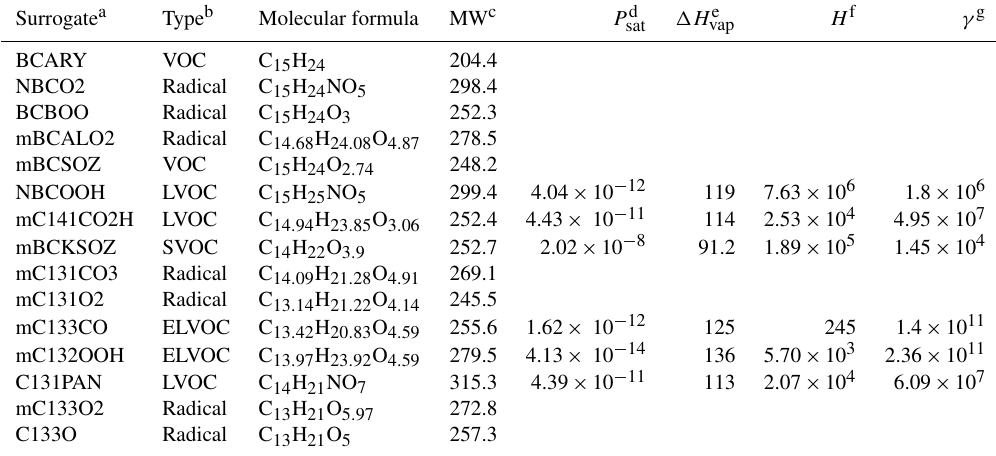
Table B1. Species list of the Rdc. mechanism. Notice that the species in the reduced case may be different from the MCM species with identical names.